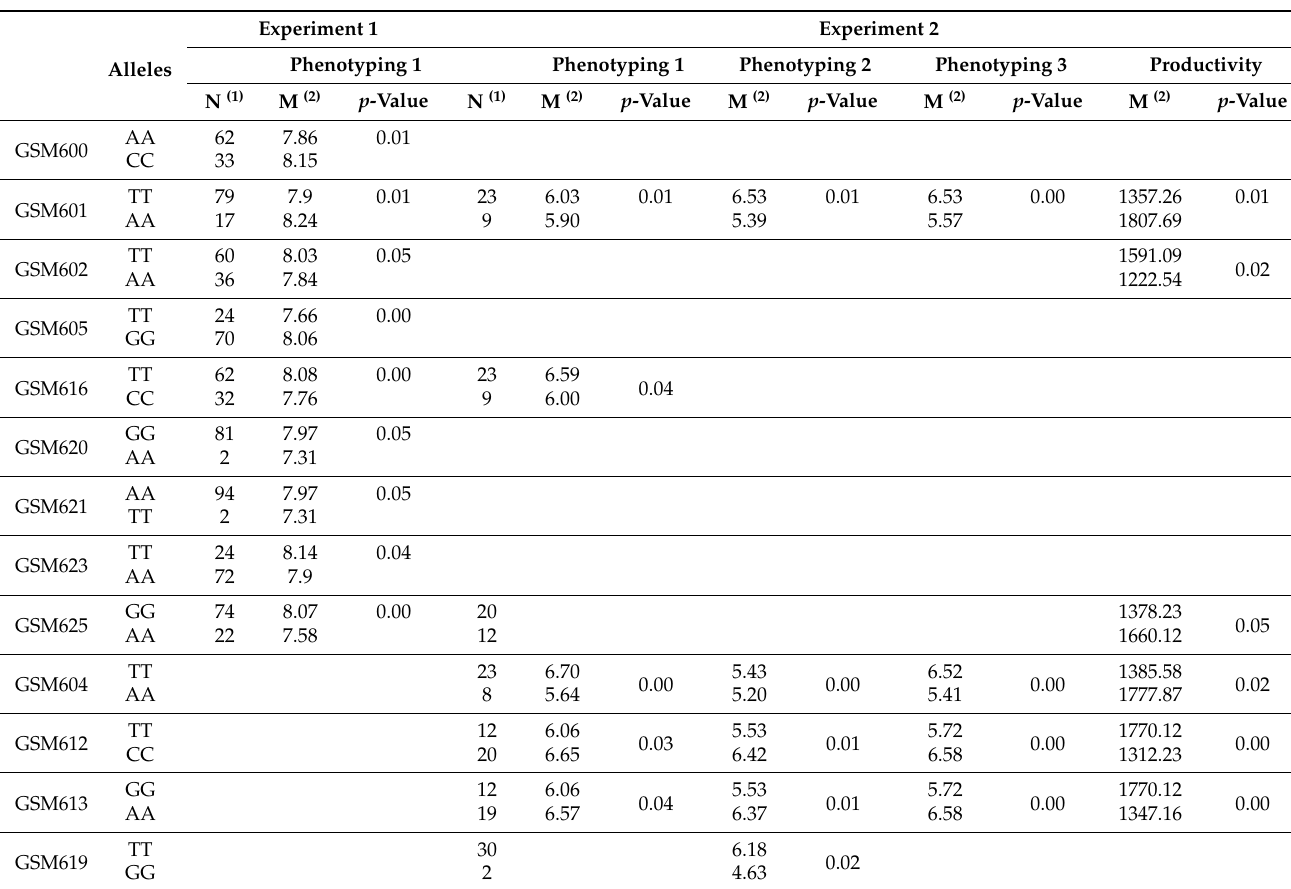
Table 5. Associative analysis of SNP markers and phenotyping (visual score and productivity) of soybean Brazilian genotypes submitted to flooding (Experiments 1 and